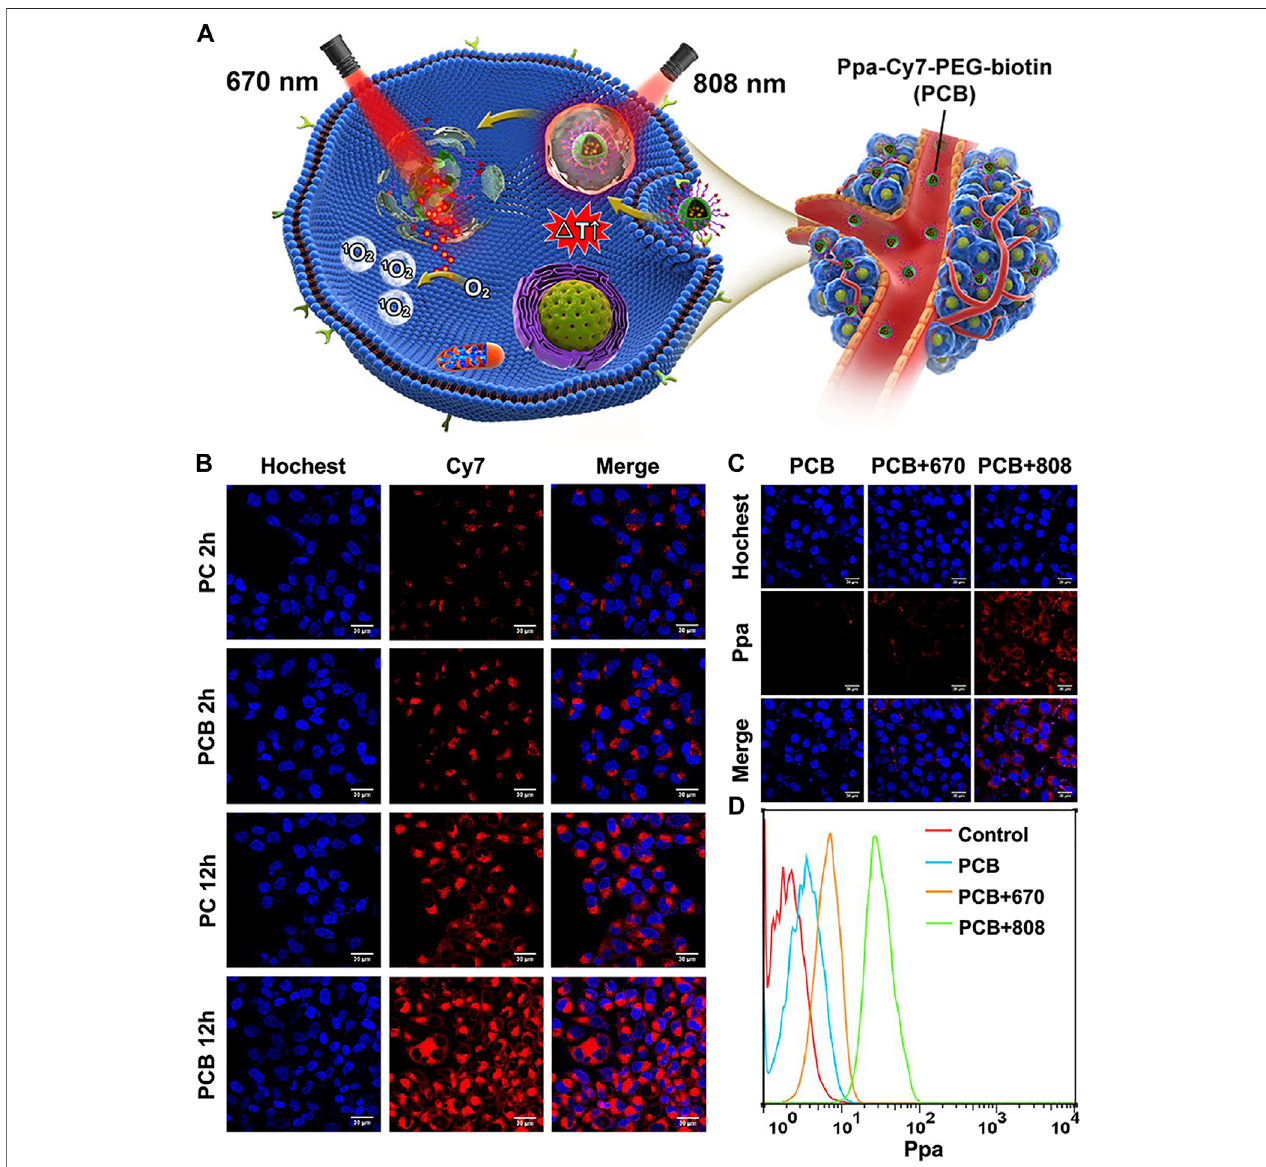
FIGURE 5 | Application of PCB in tumor-combined phototherapy and characteristics of nanoparticles. Reproduced with permission from (Xue et al., 2019). (A) . Chemical structures and formation of Ppa-Cy7-PEG-biotin (PCB) and its application in NIR light activated multi-step phototherapy for the tumor. (B) . Confocal fl uorescence images for comparing cell uptake of PC and PCB in HepG2 cells. Blue fl uorescence is the cell nucleus stained with Hoechst; red fl uorescence is the fl uorescence of Cy7. (C) . Confocal fl uorescence images for comparing intracellular release behavior of Ppa from PBC under different irradiations after incubation with PCB. Red fl uorescence stands for the fl uorescence of Ppa. (D) . Flow cytometry for analyze release and activation behavior of Ppa from PCB with irradiations of different wavelengths.